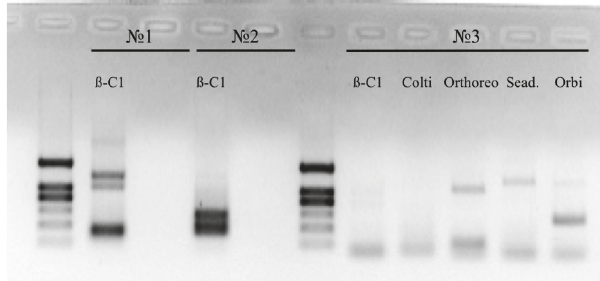
Figure 2: Reamplification of the multiplex PCR product; ß-C1: Betacoronavirus -specific primers; Colti: coltivirus-specific primers; Orthoreo: Orthoreovirus -specific primers; Sead.: Seadornavirus- specific primers; Orbi: orbivirus-specific